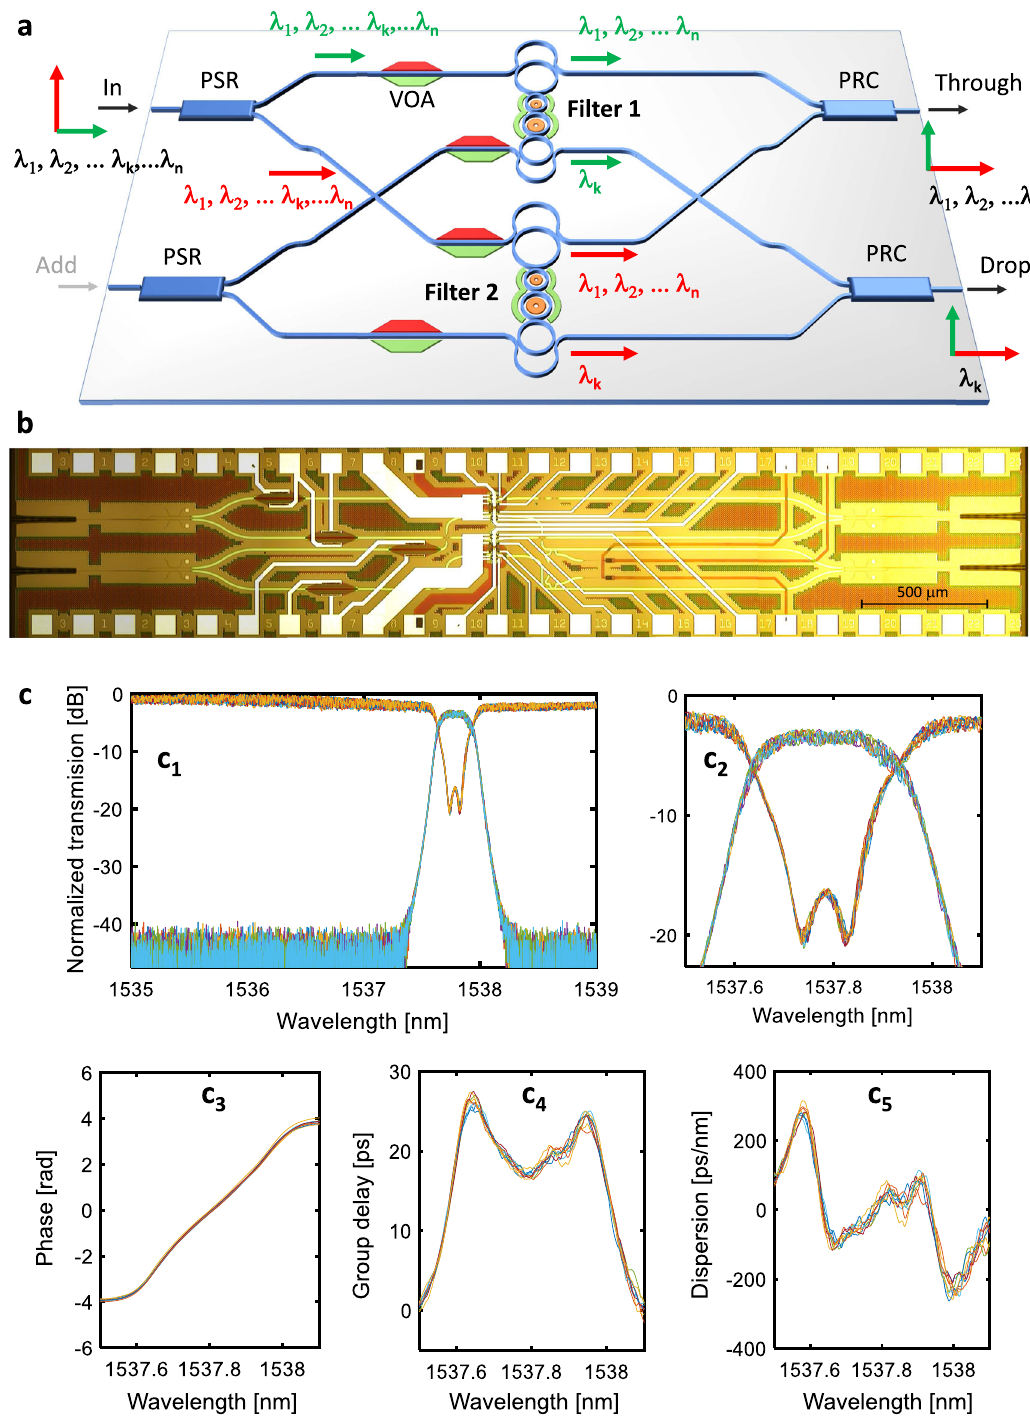
Fig. 3 Polarization independent fi lter. a Two identical hitless Vernier fi lters are integrated in a balanced polarization diversity scheme including polarization splitters and rotators (PSRs) at the input and polarization rotators and combiners (PRCs) at the outputs. Both fi lters operate on the TE mode and VOAs are used for tuning and calibration; b Top view microphotograph of the whole fi lter; c Drop and Through ports spectral response measured with a polarization scrambler at the input. Each point of the curves is a different polarization. Details of intensity (c 2 ), phase (c 3 ), group delay (c 4 ) and dispersion (c 5 ) of the drop port of the fi lter show the extremely low polarization the B2B transceiver BER performance with an induced crosstalk equal to the in-band rejection of the fi lter ( − 19 dB, dashed lines) and for both signal rates the FEC of the transceiver can recover an error free condition when the curve is below the 2e-2 FEC threshold (see Supplementary Sec. 7 and 8 for details).